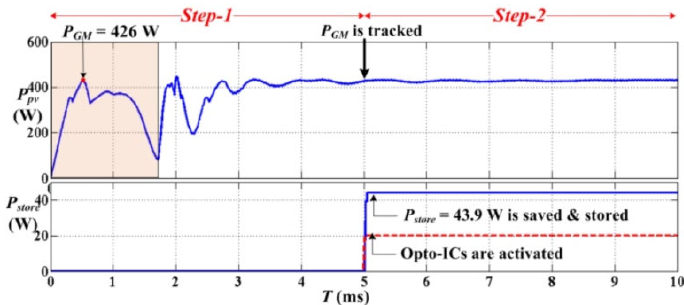
Figure 13 . Case 2: PV output power is increased by almost 44 W . Figure 13. Case 2: PV output power is increased by almost 44 W.